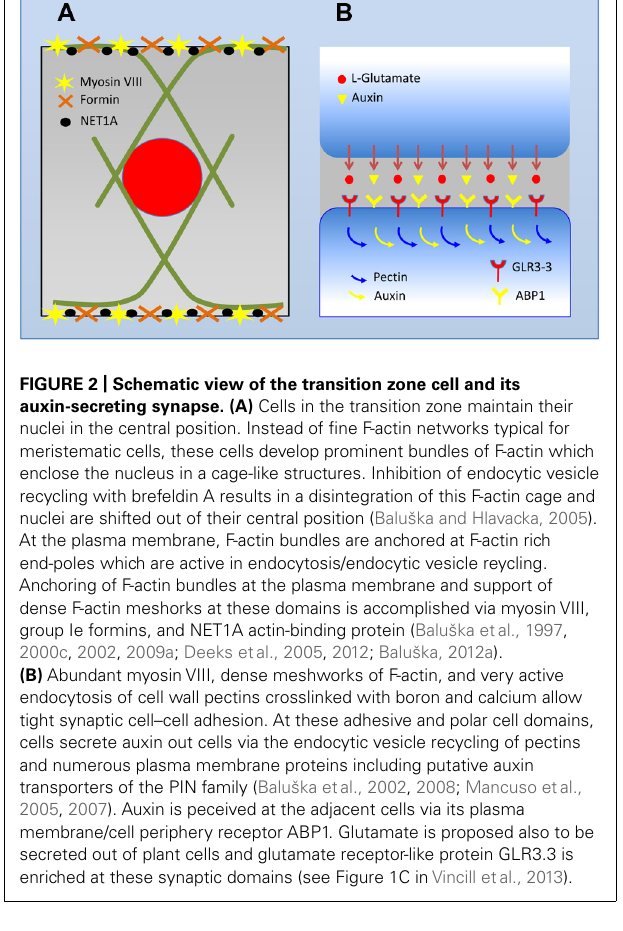
and 4 ) of the plasma membrane and associated recycling